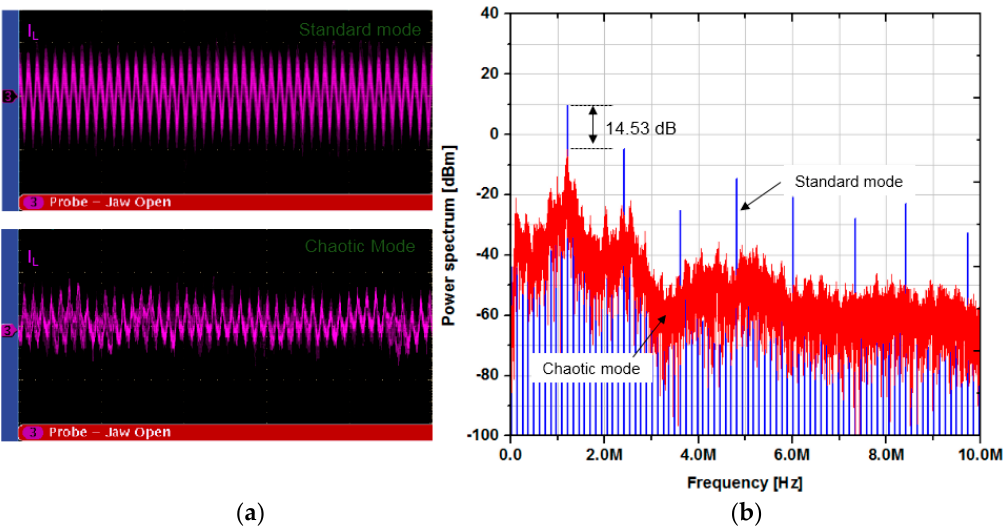
Figure 18. Measurement result of the fabricated chip: ( a ) Inductor current of the standard mode (top) and chaotic mode (bottom) (measurement mode: AC coupling @DC level: 0 V); ( b ) Power spectrum calculation results.